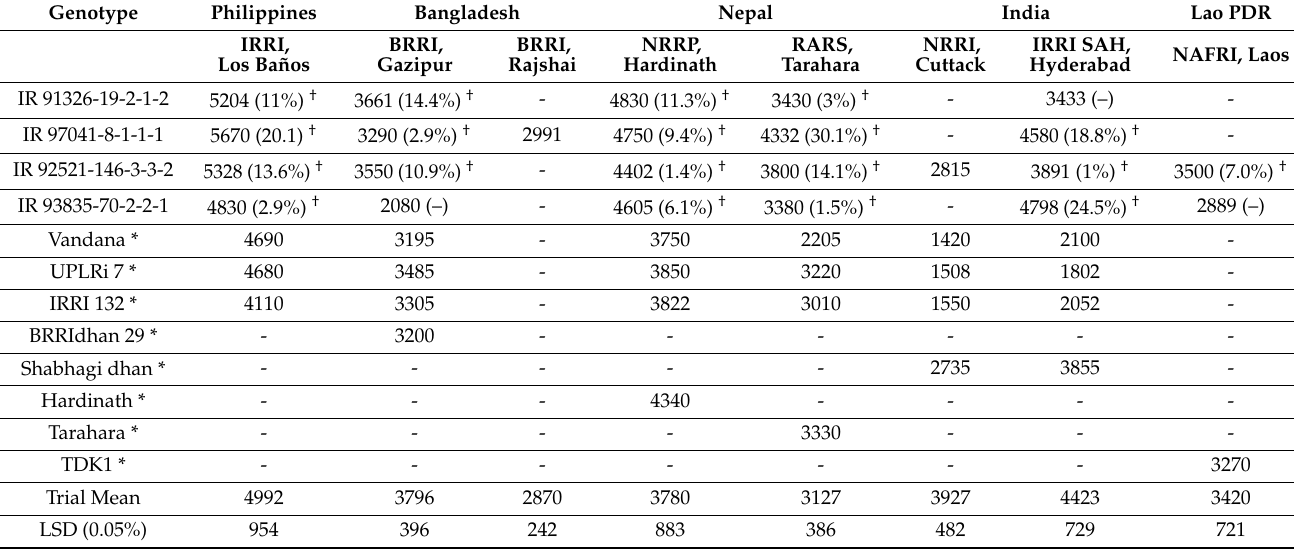
Table 6. Mean grain yield (Kg ha − 1 ) of the selected promising genotypes across diverse ecosystems under DSR conditions. Genotype